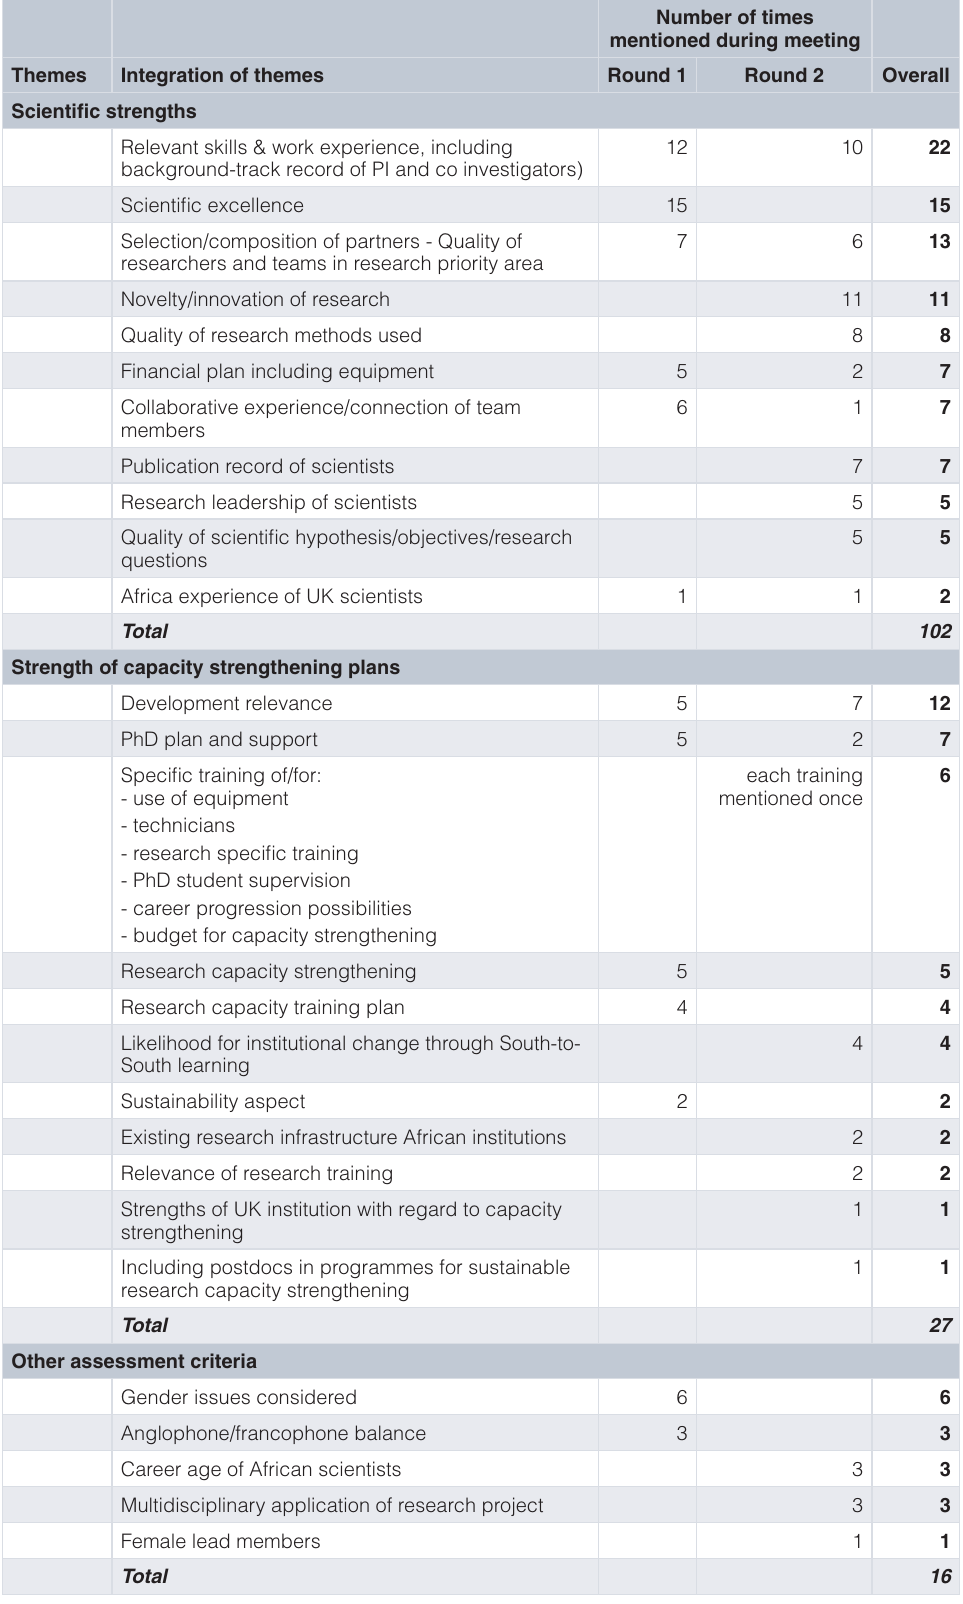
Number of times mentioned during meeting